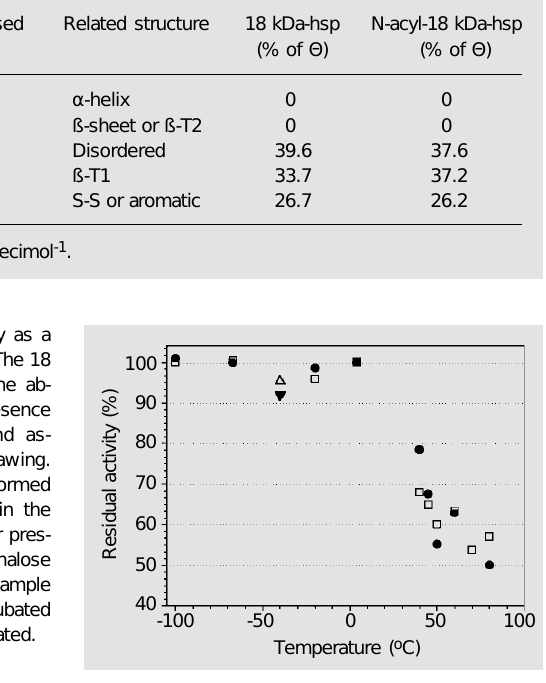
Table 1. The 18 kDa-hsp and N-acyl-18 kDa-hsp secondary structures. Spectral signal (expressed Related structure 18 kDa-hsp N-acyl-18 kDa-hsp